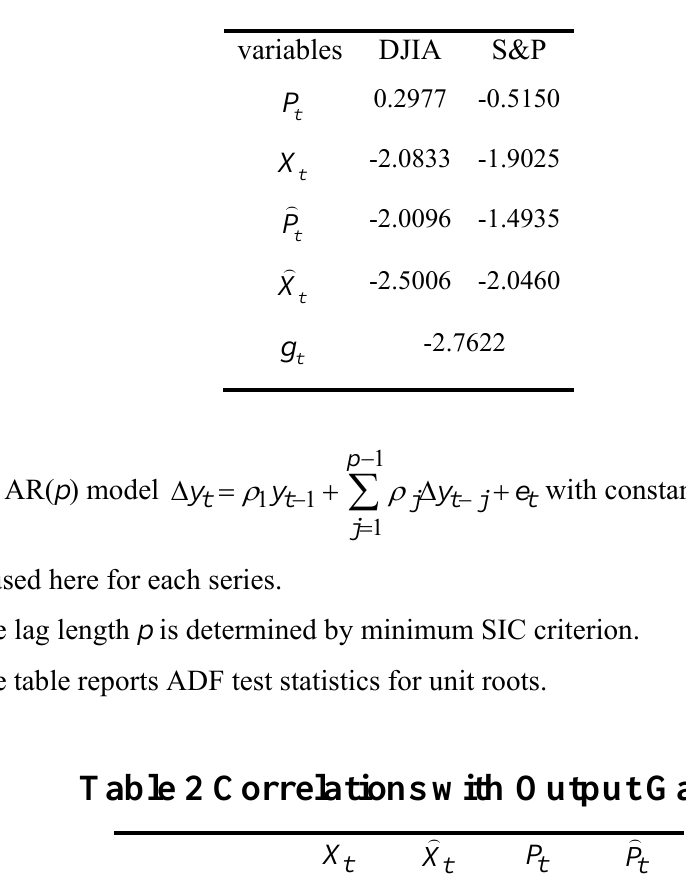
Table 1 Unit Root Tests